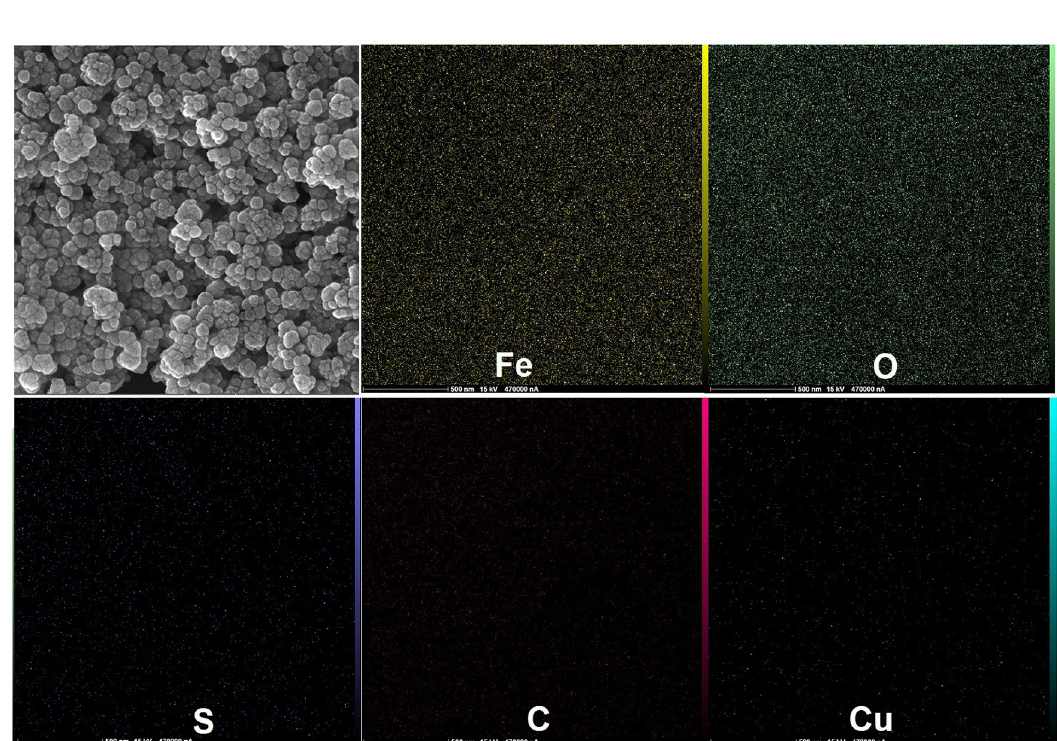
Figure 6. SEM mapping of Fe 3 O 4